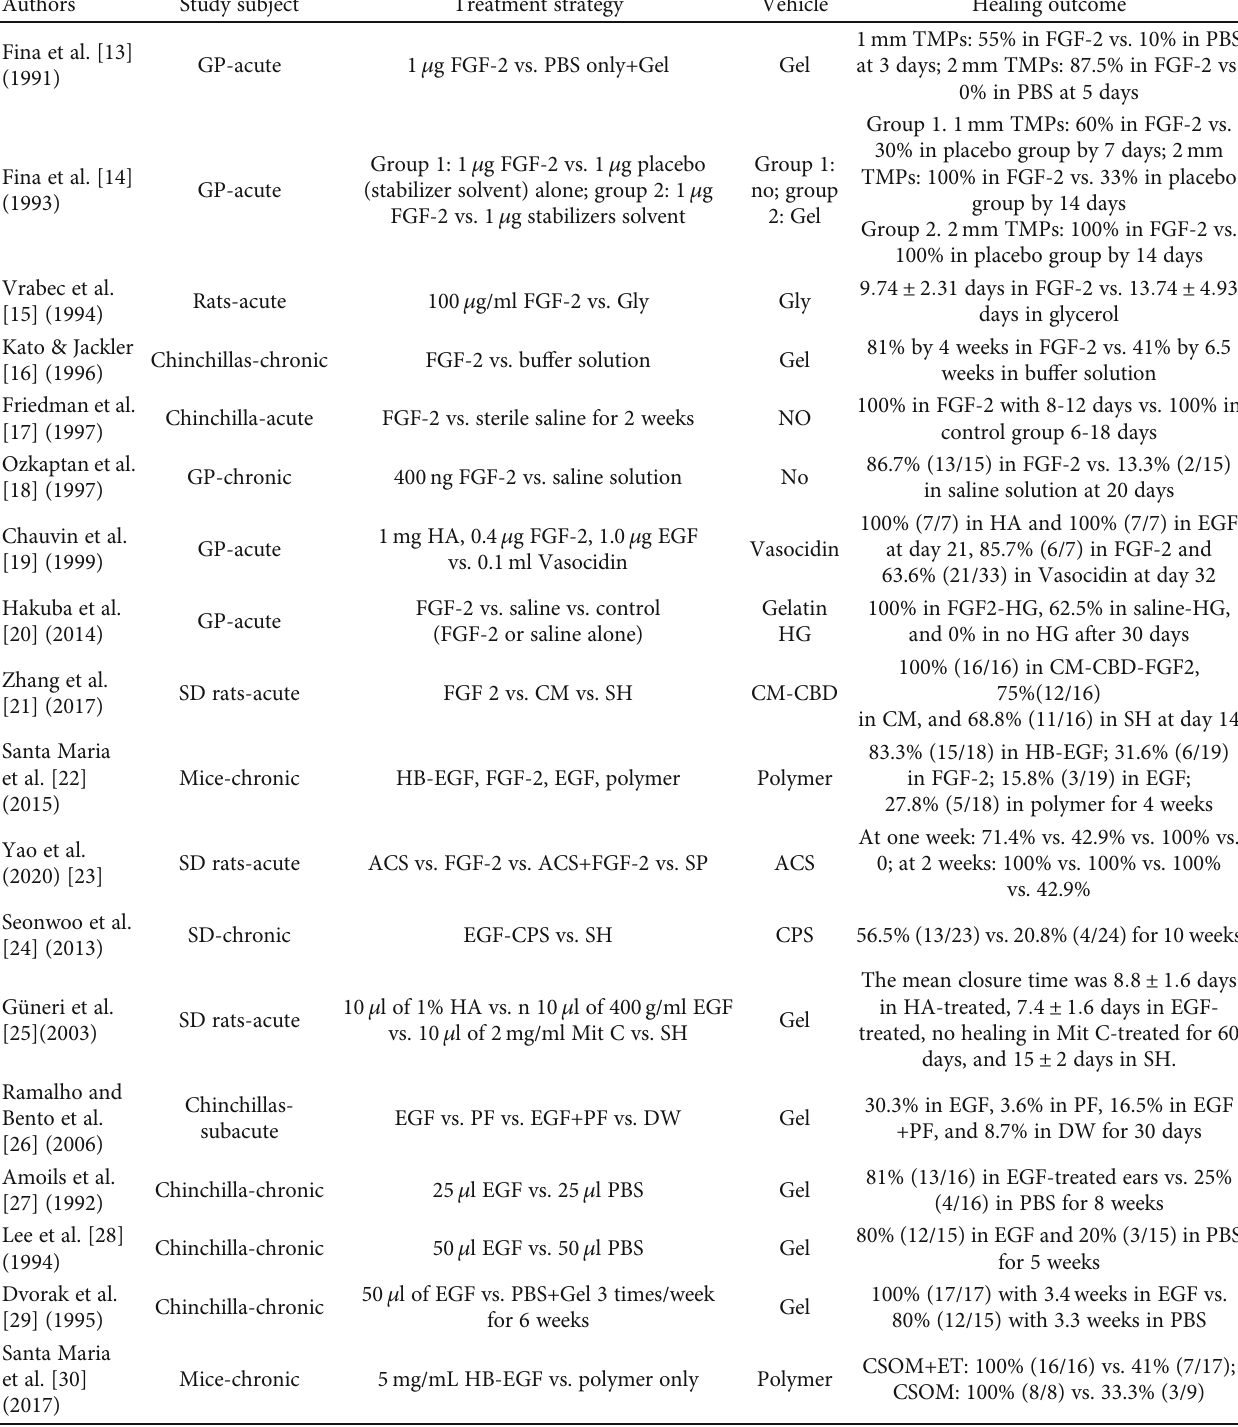
Table 1: Summary of FGF2 and EGF e ff ects on experimental